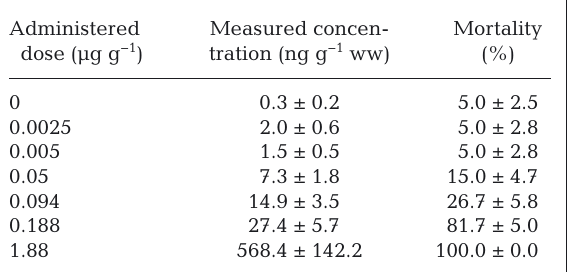
Table 1. Mortality and measured teflubenzuron concentra- tions (mean ± SE) in rockpool shrimp following a 66 d oral administration period. ww: wet